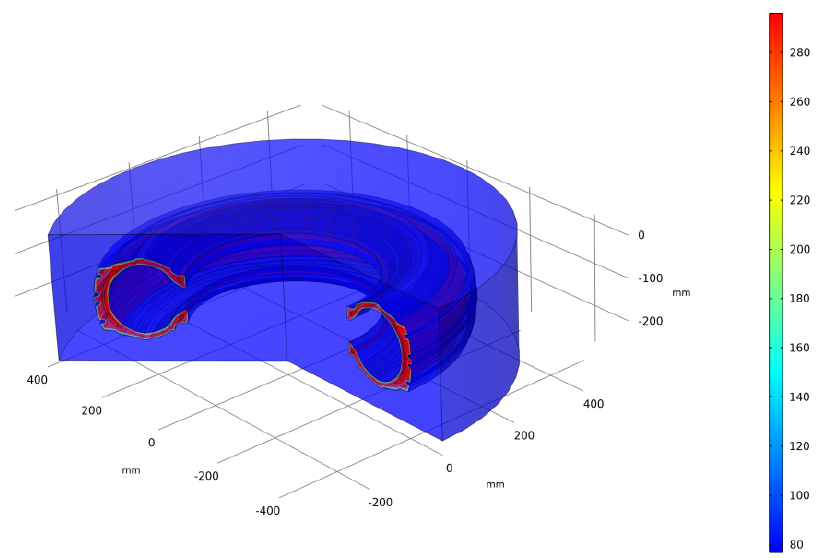
Figure 6. Computer model illustration.